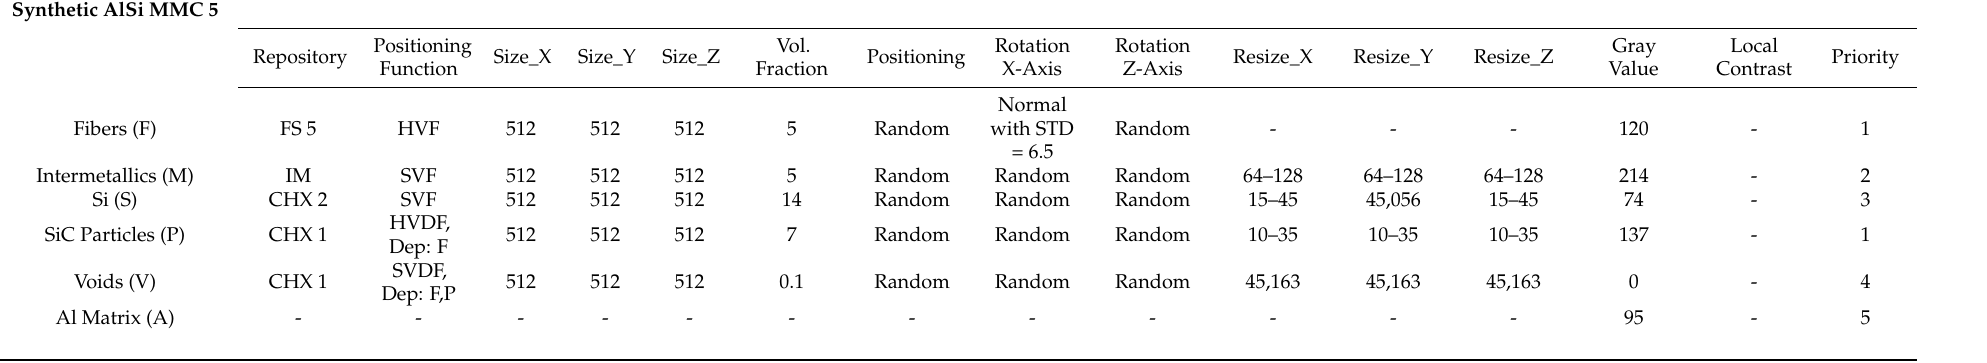
Table A2. Synthetic Al–Si MMCs 5–8